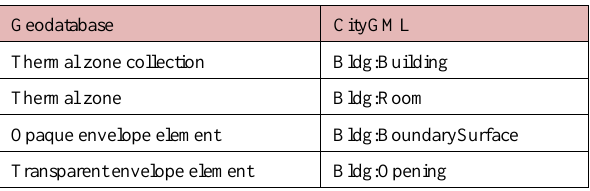
Table 1: correlation between the geodatabase entities and CityGML